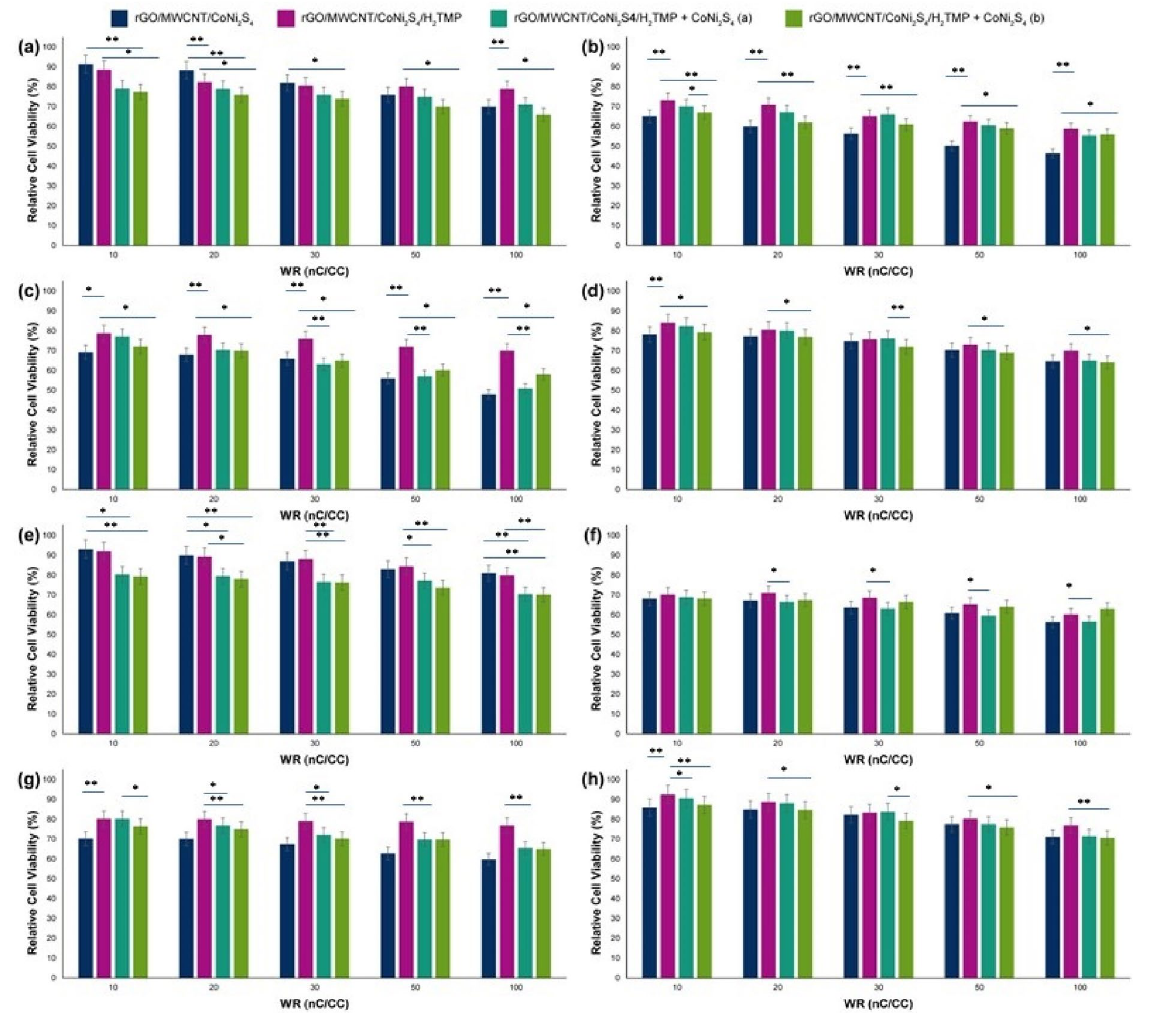
Figure 5. MTT results of the rGO/MWCNT/CoNi 2 S 4 , rGO/MWCNT/CoNi 2 S 4 /H 2 TMP, rGO/MWCNT/ CoNi 2 S 4 /H 2 TMP + CoNi 2 S 4 ( a ) and rGO/MWCNT/CoNi 2 S 4 /H 2 TMP + CoNi 2 S 4 ( b ) on the ( a ) HEK-293, ( b ) HeLa, ( c ) HepG2 and ( d ) PC12 cell lines after treatment time of 48 h; and rGO/MWCNT/CoNi 2 S 4 , rGO/ MWCNT/CoNi 2 S 4 /H 2 TMP, rGO/MWCNT/CoNi 2 S 4 /H 2 TMP + CoNi 2 S 4 ( a ) and rGO/MWCNT/CoNi 2 S 4 / H 2 TMP + CoNi 2 S 4 ( b ) on the ( e ) HEK-293, ( f ) HeLa, ( g ) HepG2 and ( h ) PC12 cell lines after treatment time of 24 h; ( a ) represents for 10 mg mL −1 and ( b ) 20 mg mL −1 concentrations of the excess CoNi 2 S 4 . *p value < 0.05 and **p value <